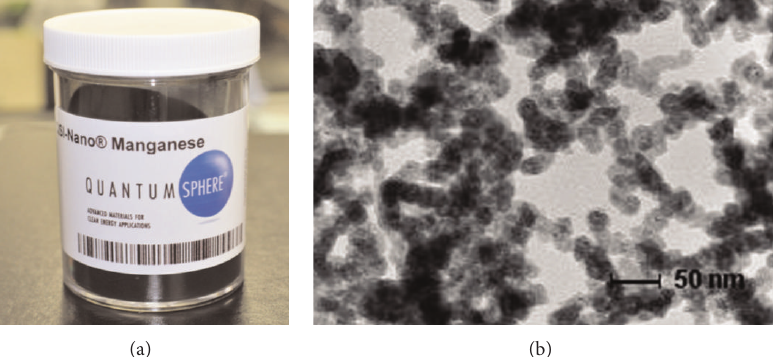
Figure 13: QuantumSphere’s QSI-Nano Manganese catalyst powder (a) and electron microscope picture of the core-shell nanoparticles (b) [13] (used with permission from QuantumSphere